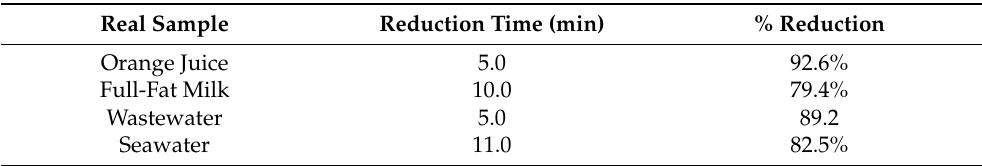
Table 2. Application of CMC/CuO-TiO 2 nanocatalyst beads on four types of real samples spiked with 4-NP.